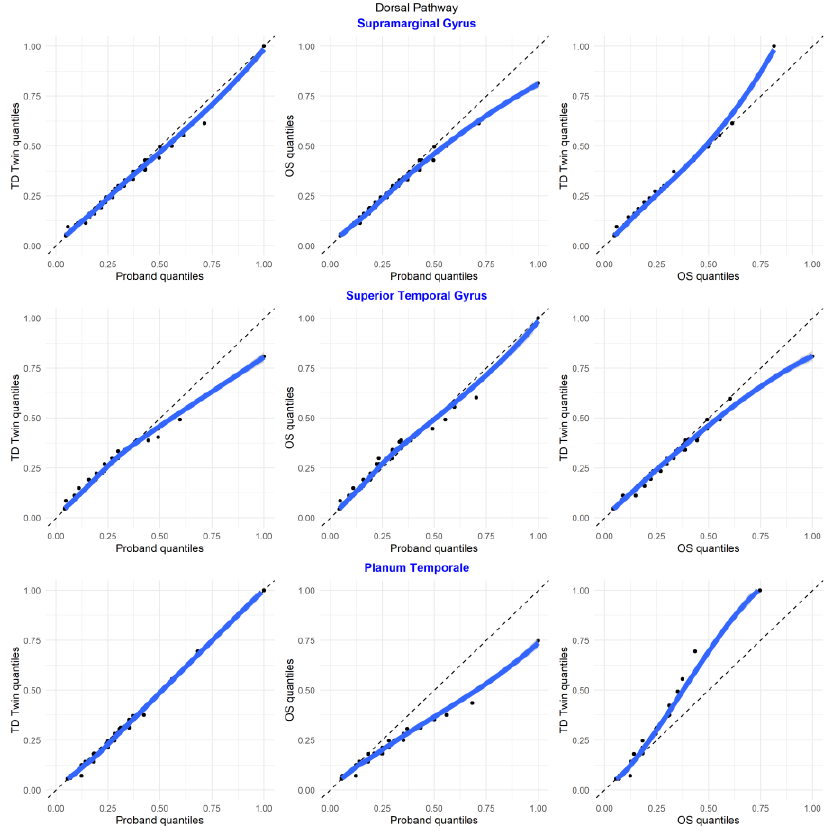
Figure 8. Select Q – Q plots of sibling comparisons of regions in the dorsal pathway. Figure 8. Select Q–Q plots of sibling comparisons of regions in the dorsal